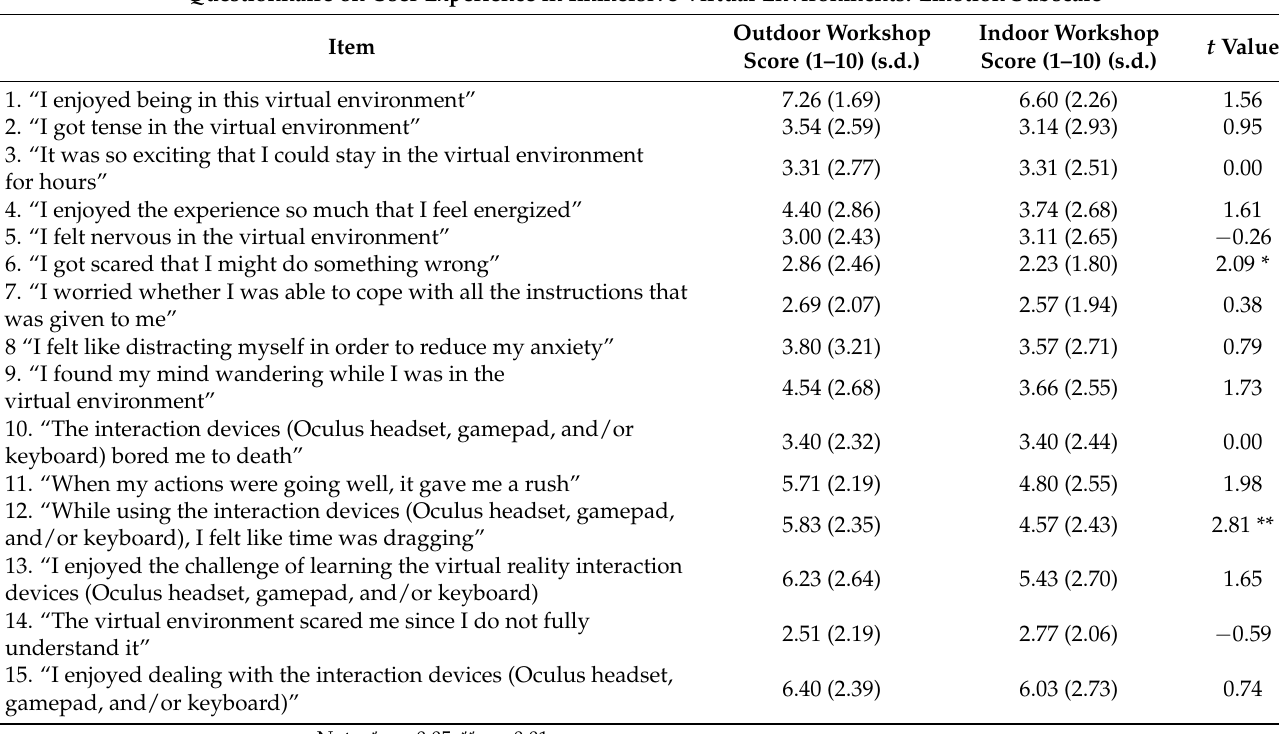
Table 8. Questionnaire on User experience in Immersive Virtual Environments: emotion subscale. Questionnaire on User Experience in Immersive Virtual Environments: Emotion Subscale